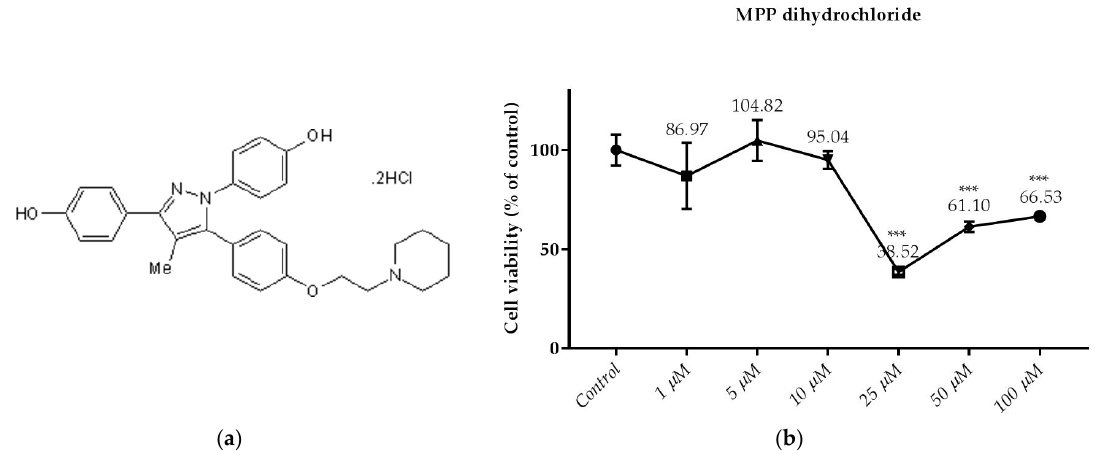
Figure 4. Dose dependent cytotoxic effects of MPP dihydrochloride was determined by SRB assay and shown for 24 h: ( a ) The molecular of MPP dihydrochloride; ( b ) Effect of MPP dihydrochloride on viability of RL95-2 cell. Cells were treated with various concentrations of MPP dihydrochloride for 24 h. The absorbance was determined after 1 h-incubation of the cells with SRB. Cell viability is presented as mean ± SD at least three independent experiments. *** p < 0.001 compared with the untreated control.